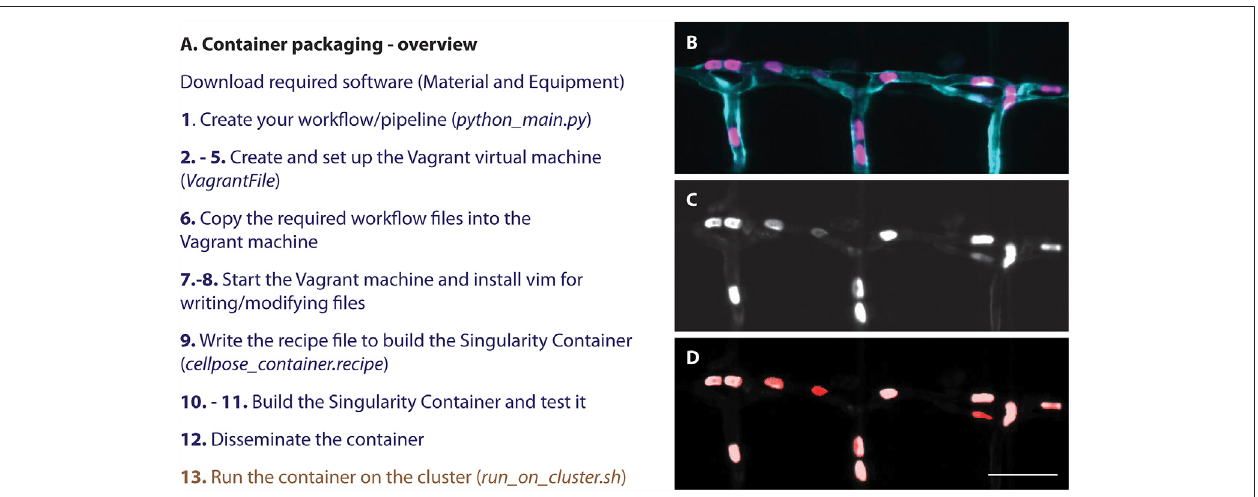
FIGURE 2 | (A) Overview of a step-by-step protocol to establish a Singularity container. While an image analysis specialist of a facility is required to follow all steps (blue), an end user only needs to run the container (brown) and therefore does not have to deal with setting up the software and its dependencies correctly. (B – D) Resulting segmentation from applying the here described container: (B) Still image of red blood cells (magenta) labelled with Tg (Gata1a:dsRed) (Traver et al., 2003) in a zebra fi shembryowithavascularmarker(cyan)Tg(kdrl:eGFP)(Jinetal.,2005). (C) Greyscaleimageofthelabelledredbloodcells (D) Resultingsegmentation(red) overlayed on the grey scale image (C) . Scalebar: 50